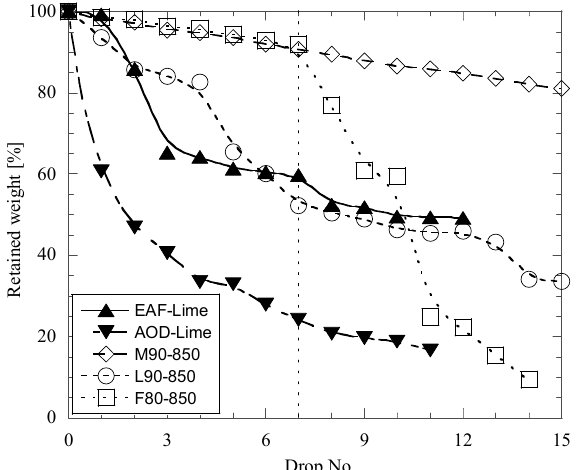
Figure 8. Comparison of drop test results for the best metallurgical briquettes (M90-850, L90-850 and F80-850) and lime lumps for electric arc furnaces (EAF) and argon oxygen decarburization (AOD) converter.